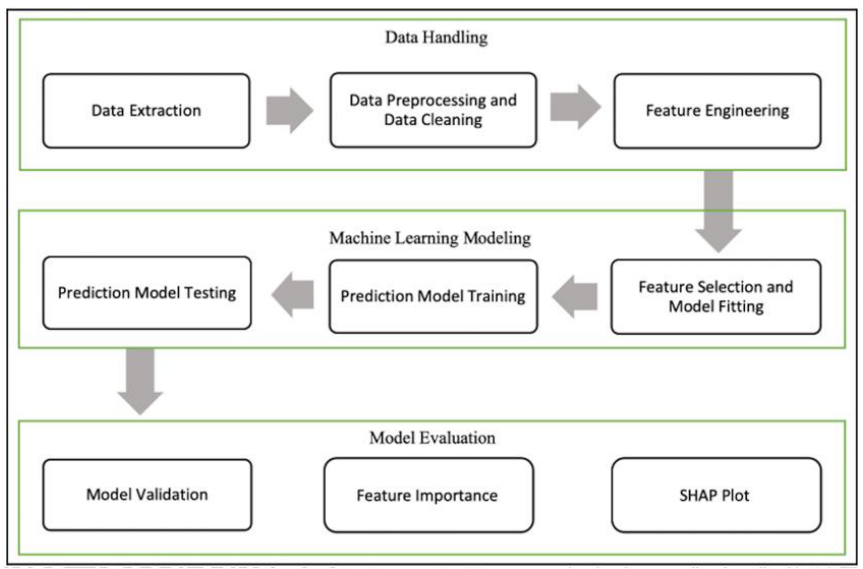
Figure 1. Methodology. The three components are data handling, machine learning modeling, and model evaluation. The steps within each component are explained in this section.